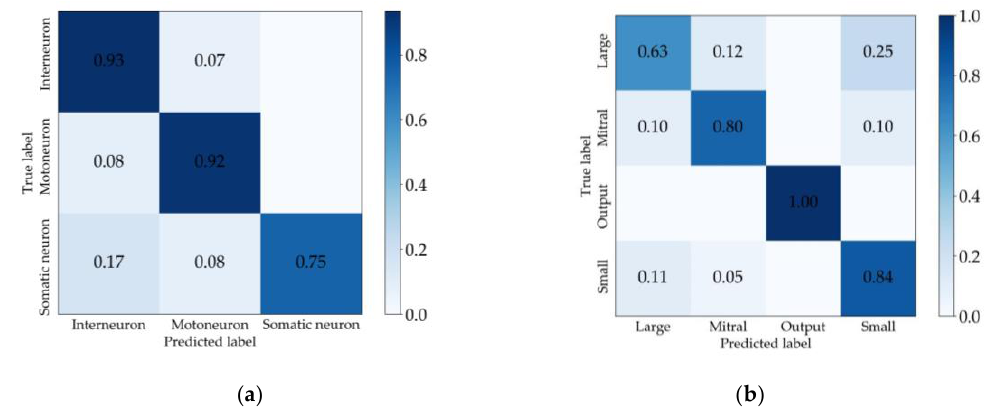
15 of 19 Figure 15. Comparison of accuracy with different numbers of building blocks by LCCDNNs. ( a ) C. elegans dataset, ( b ) zebrafish dataset. ( a ) ( b ) Figure 16. Comparison of accuracy with different numbers of building blocks by FCCDNNs. ( a ) C. elegans dataset, ( b ) zebrafish dataset. 4.3.4. Comparison Experiment of Accuracy for Each Neuron Type According to the above experiments, the overall classification accuracies of different types of neurons were compared for two kinds of neuron datasets by using LCCDNNs and FCCDNNs. To further validate the advantages of the cumulative connected deep neural networks, the accuracy of each neuron type is analyzed in this section. The confusion matrix was used to compare the accuracy of each neuron type for the two deep learning models in the C. elegans dataset and zebrafish dataset. Figures 17 and 18 are the confusion matrices of the test sets for the LCCDNNs and FCCDNNs, respectively. The values on the diagonals represent the classification accuracies of interneuron, motoneuron, and somatic neuron for the LCCDNN model in Figure 17a and the FCCDNN model in Figure 18a. Similarly, the values on the diagonals represent the classification accuracies of large, mitral, output, and small neuron types in Figures 17b and 18b. The color is bluer in the matrix, so the deep learning model had a better classification performance for the corresponding neuron type. It